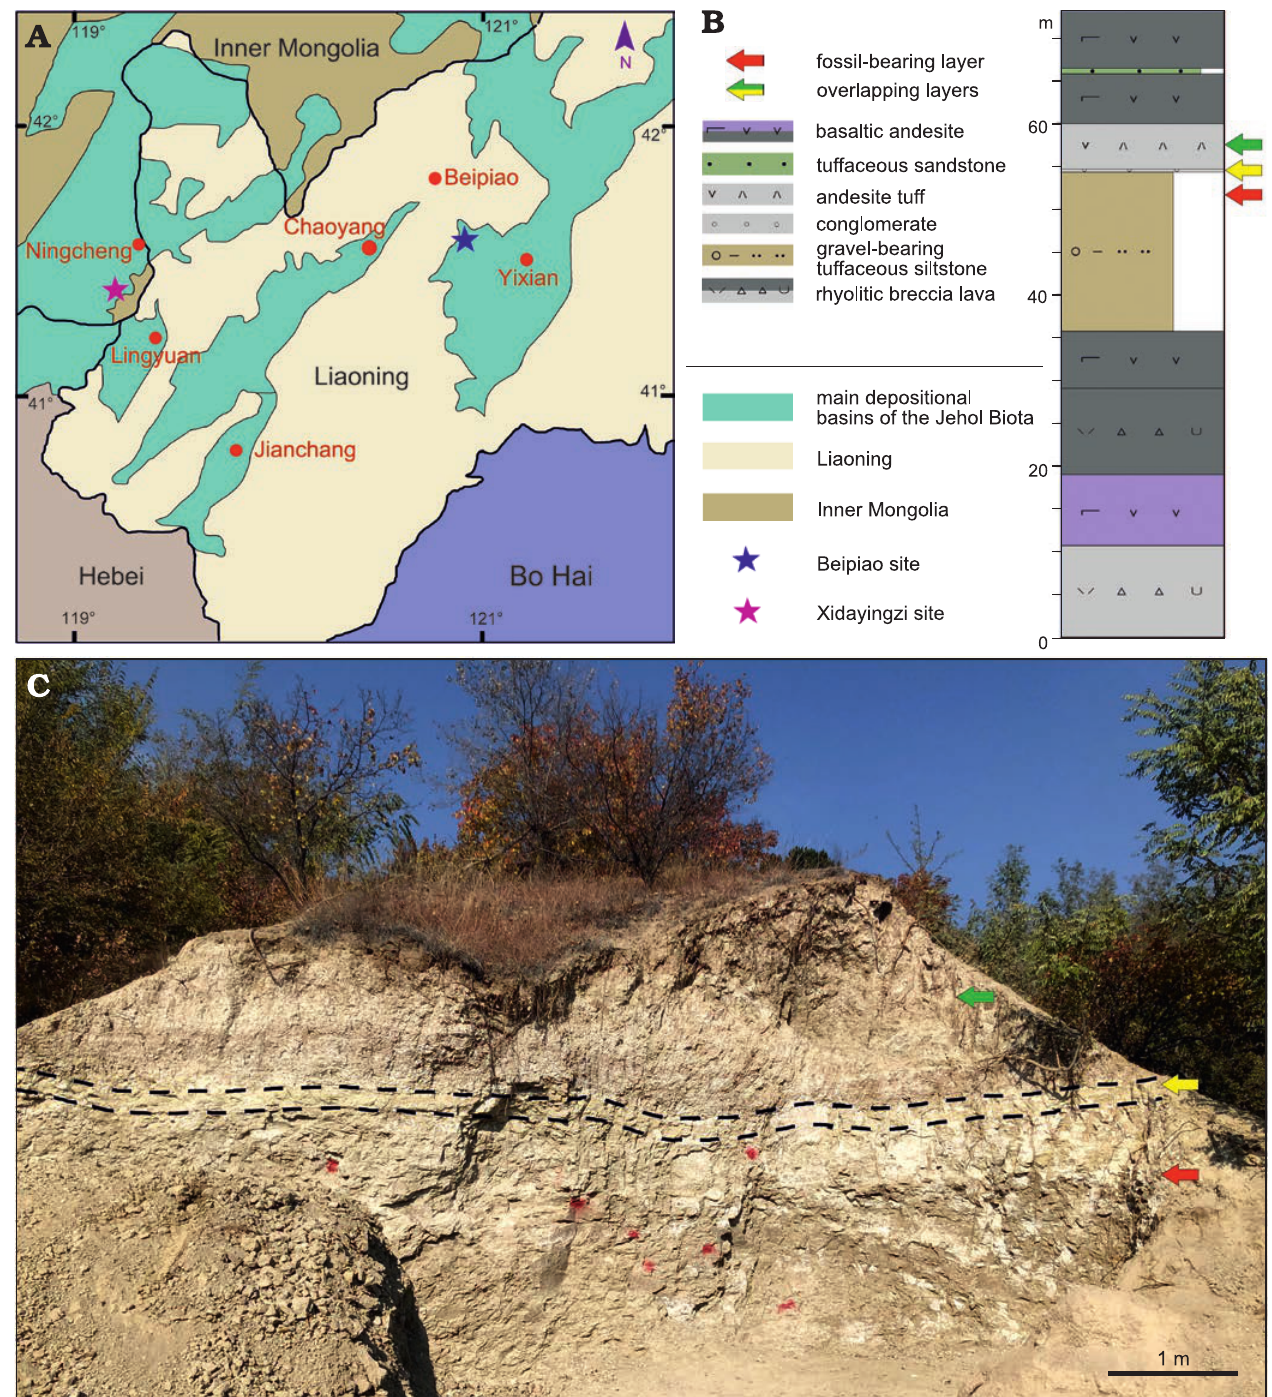
Fig. 1. Map of the Inner Mongolia, Liaoning and Hebei ( A ) showing location of the Xidayingzi site and the outcrops of the Lujiatun Unit of the Yixian Formation of the Jehol Biota in Beipiao, western Liaoning Province, China. Stratigraphic column ( B ) and corresponding photographic image ( C ) of the Early Cretaceous Xidayingzi